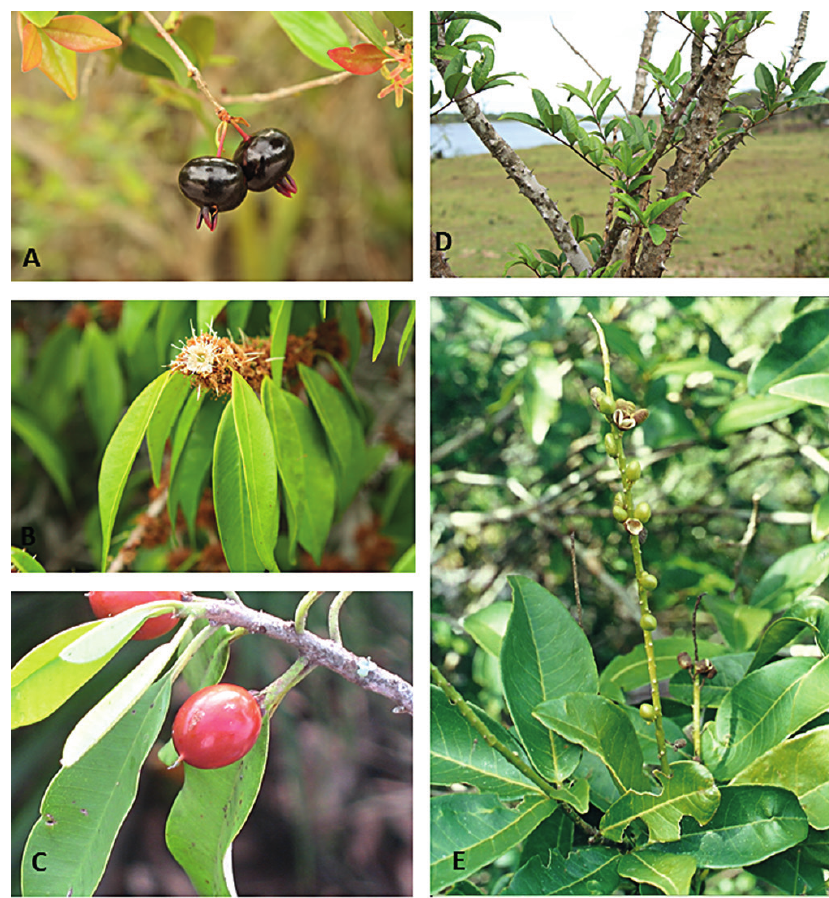
Figure 6 - Plants of Brazilian restinga vegetation. a - Eugenia sulcata , b -Myrciaria floribunda , c - Manilkara subsericea , d - Zanthoxylum caribaeum, e - Pilocarpus spicatus. Photos Marcelo guerra